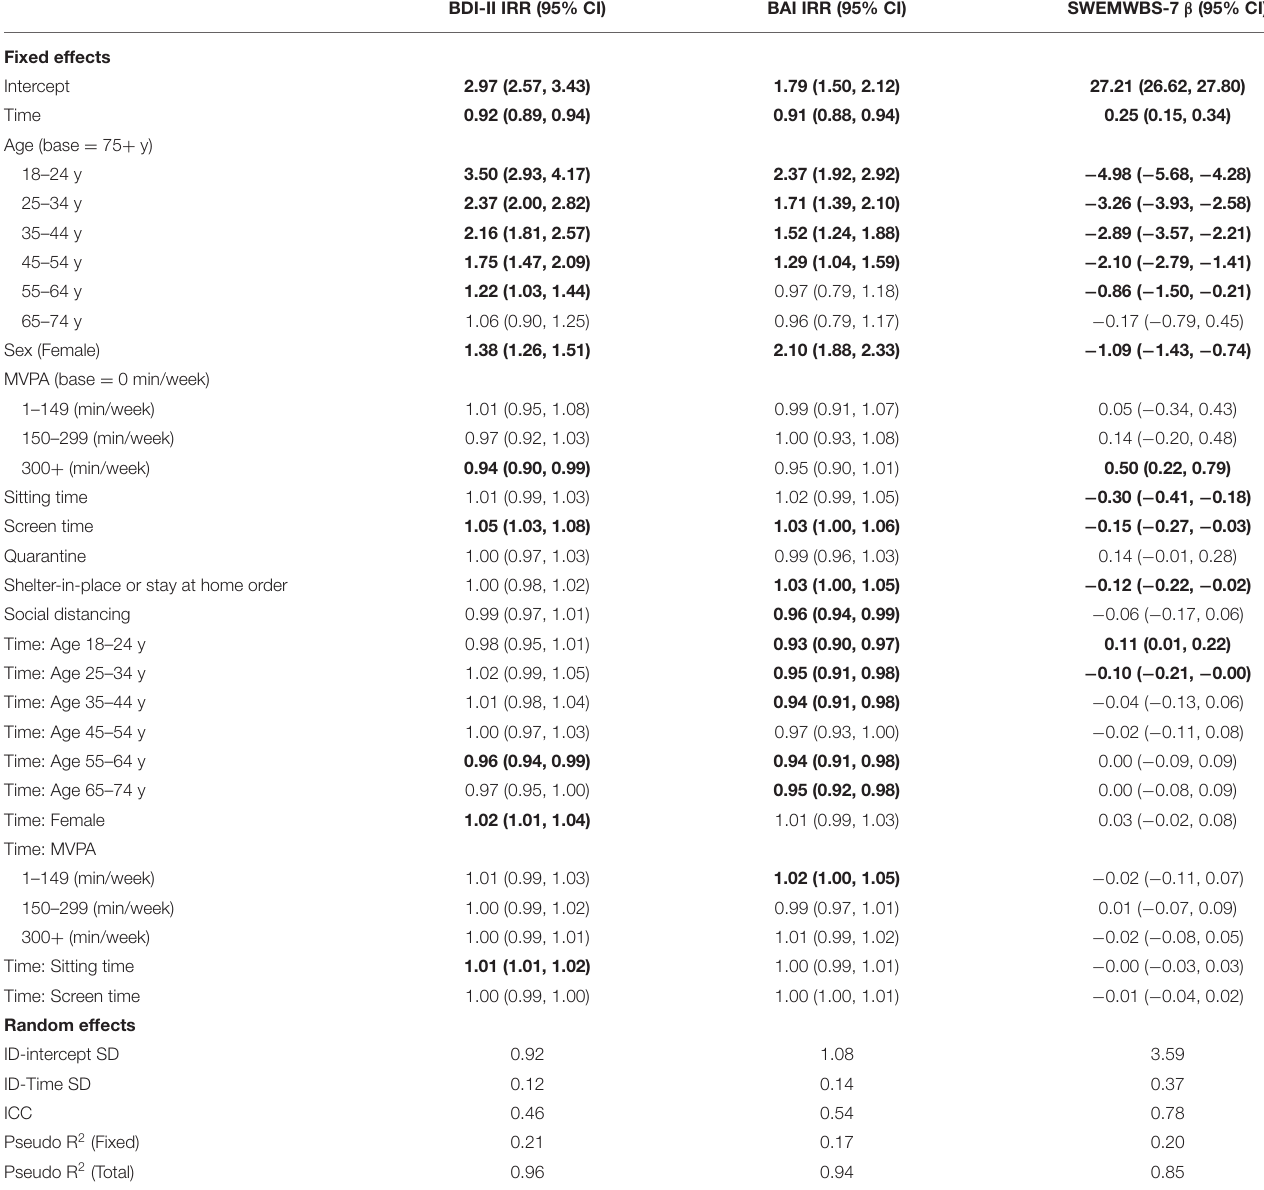
TABLE 2 | Full model results for depressive symptoms (BDI-II), anxiety symptoms (BAI), and positive mental health